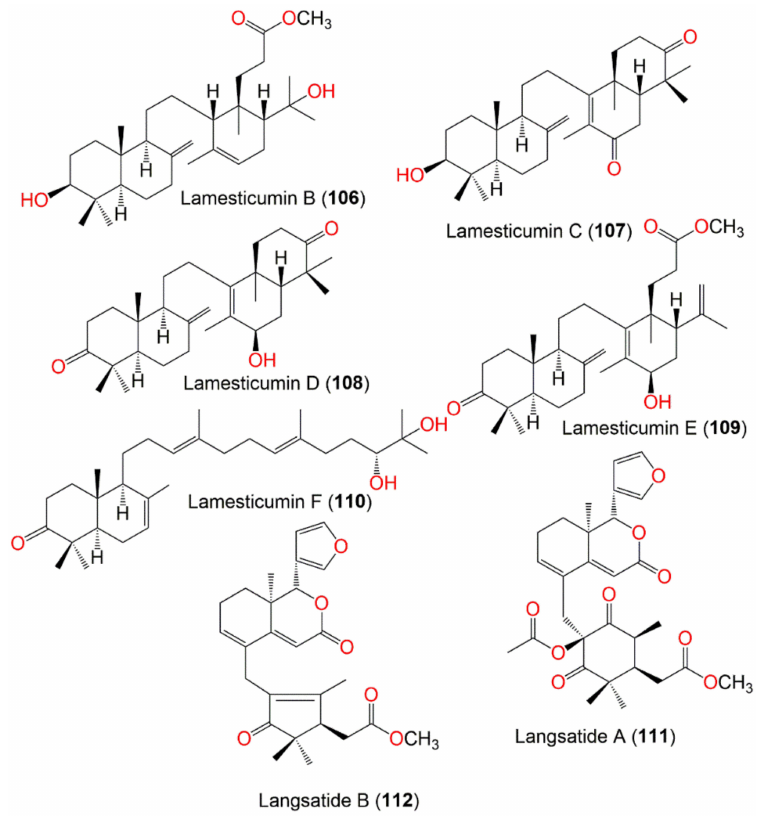
Figure 11. Structures of compounds 106 – 112 from Lansium domesticum